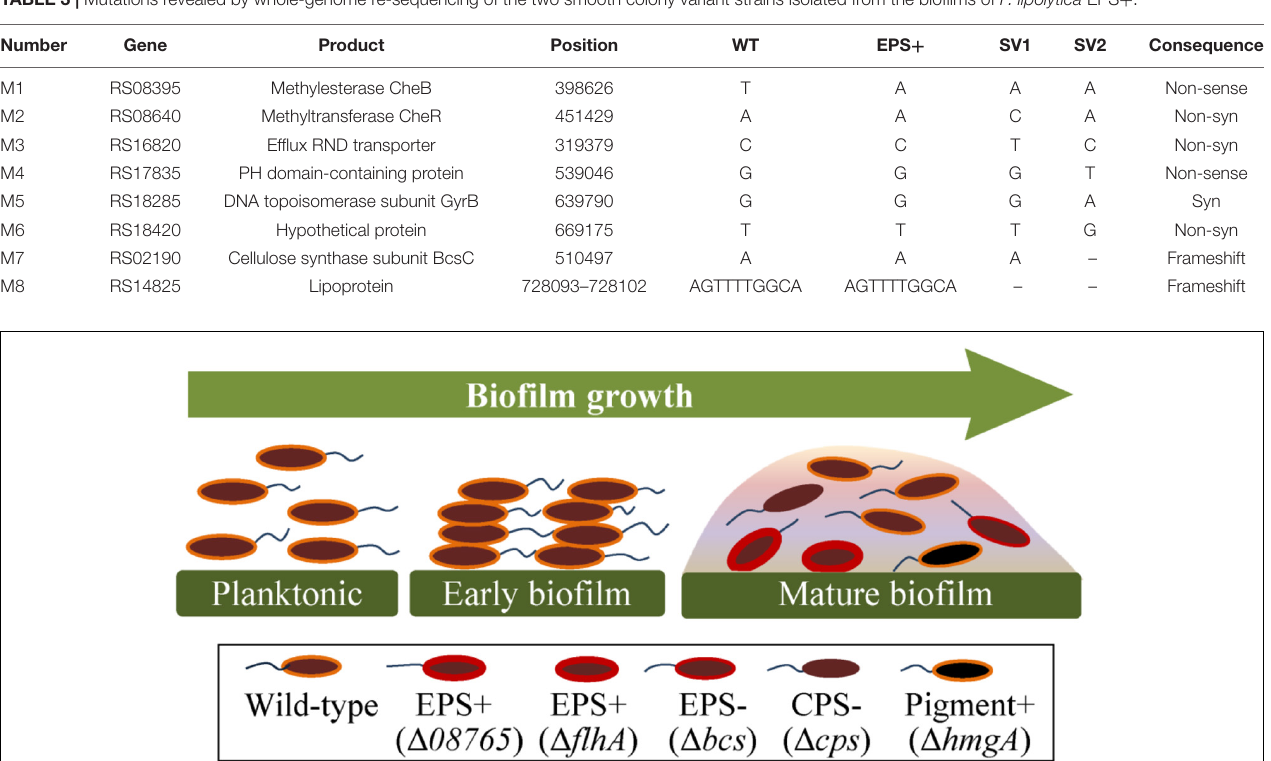
TABLE 3 | Mutations revealed by whole-genome re-sequencing of the two smooth colony variant strains isolated from the biofilms of P. lipolytica EPS + .